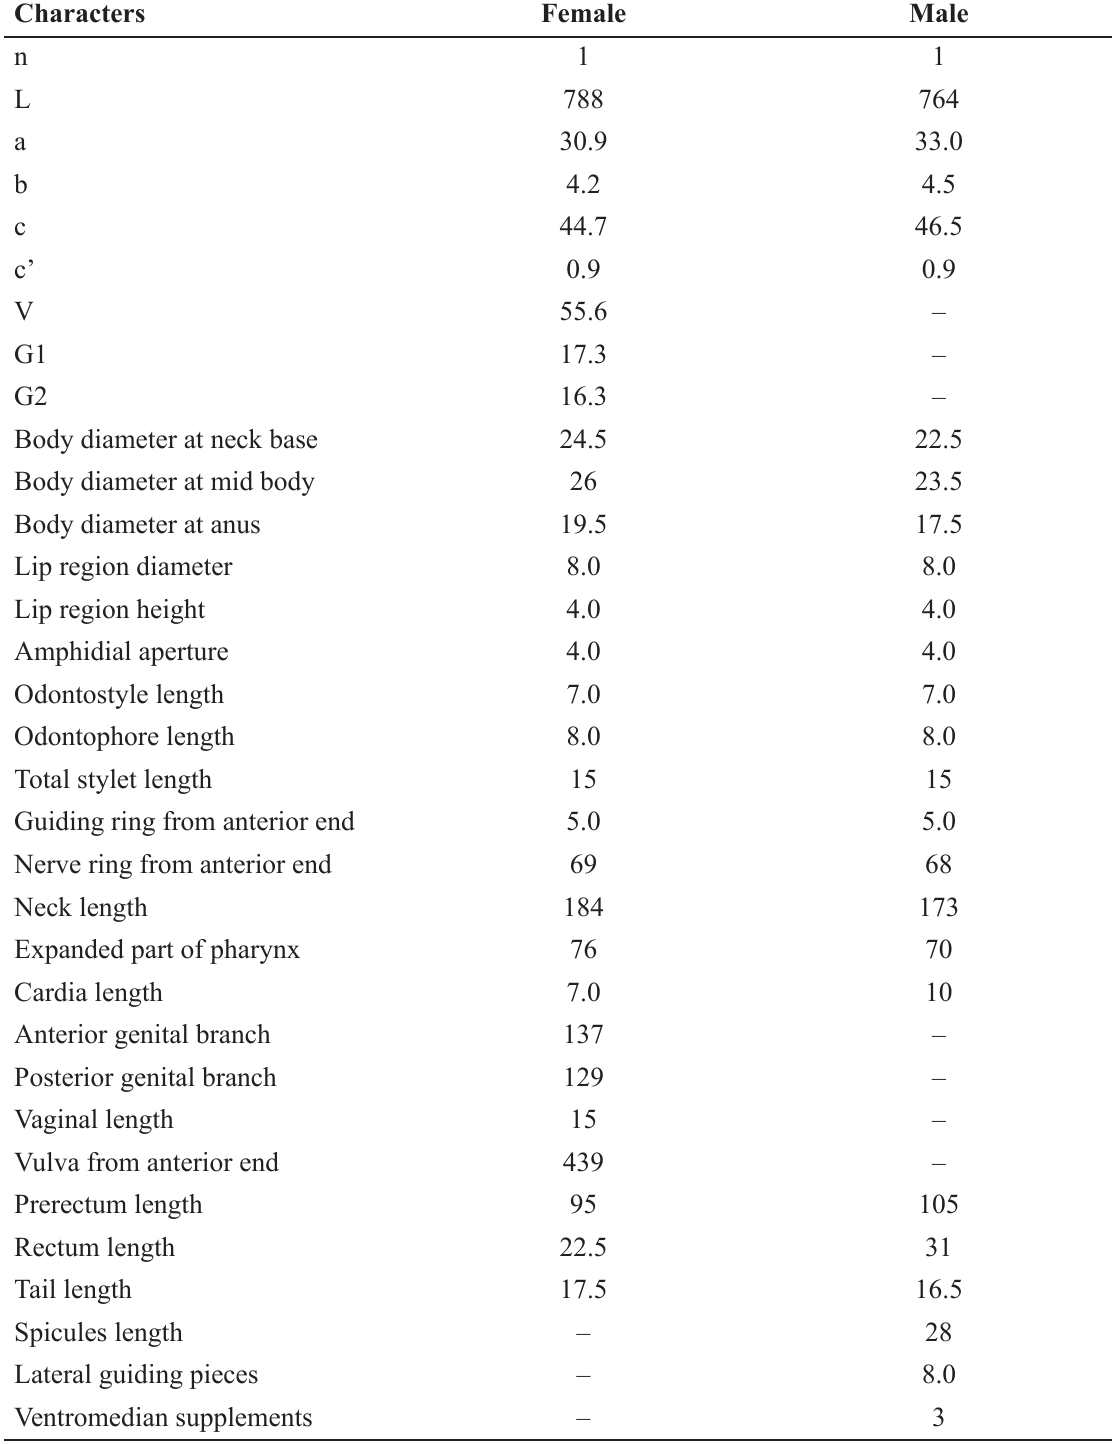
Table 2. Measurements of Tylencholaimus teres Thorne, 1939. All measurements are in µm.